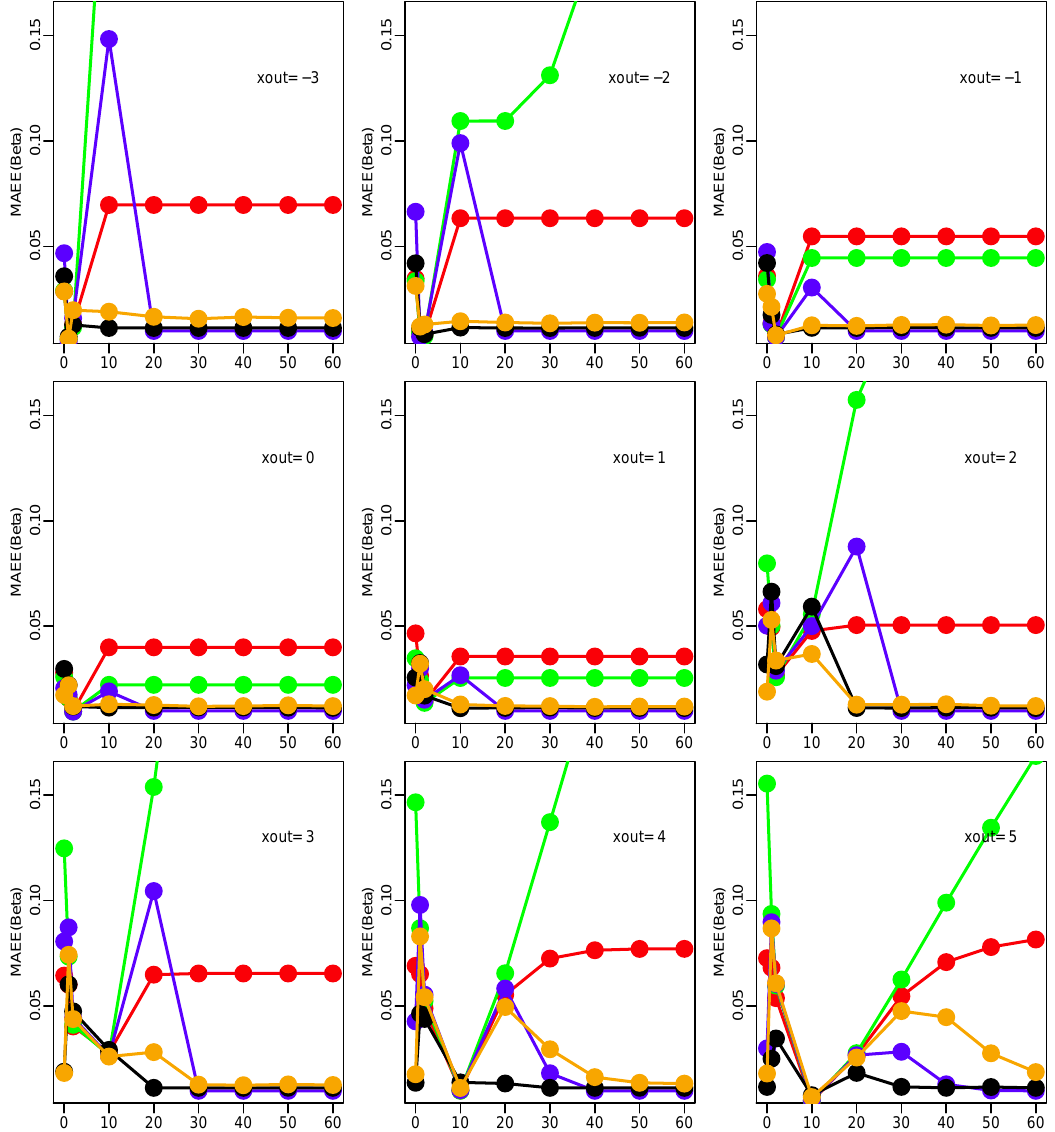
Figure 2. Monte Carlo results for the contaminated simple regression model. Mean square estimation error MSEE( ˆ β ) for varying y out and x out . RQL14, green; MT23, blue; MD04, orange; MCML10,